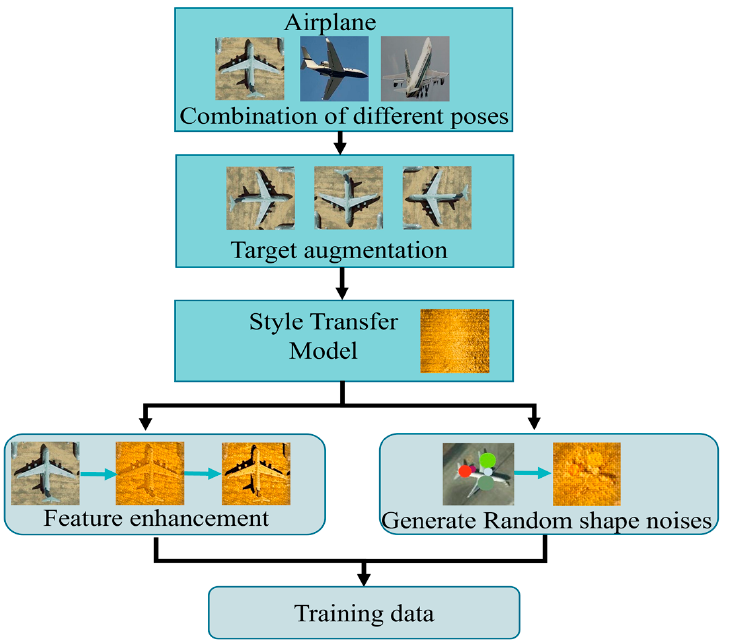
Figure 1. Data processing to generate training data.